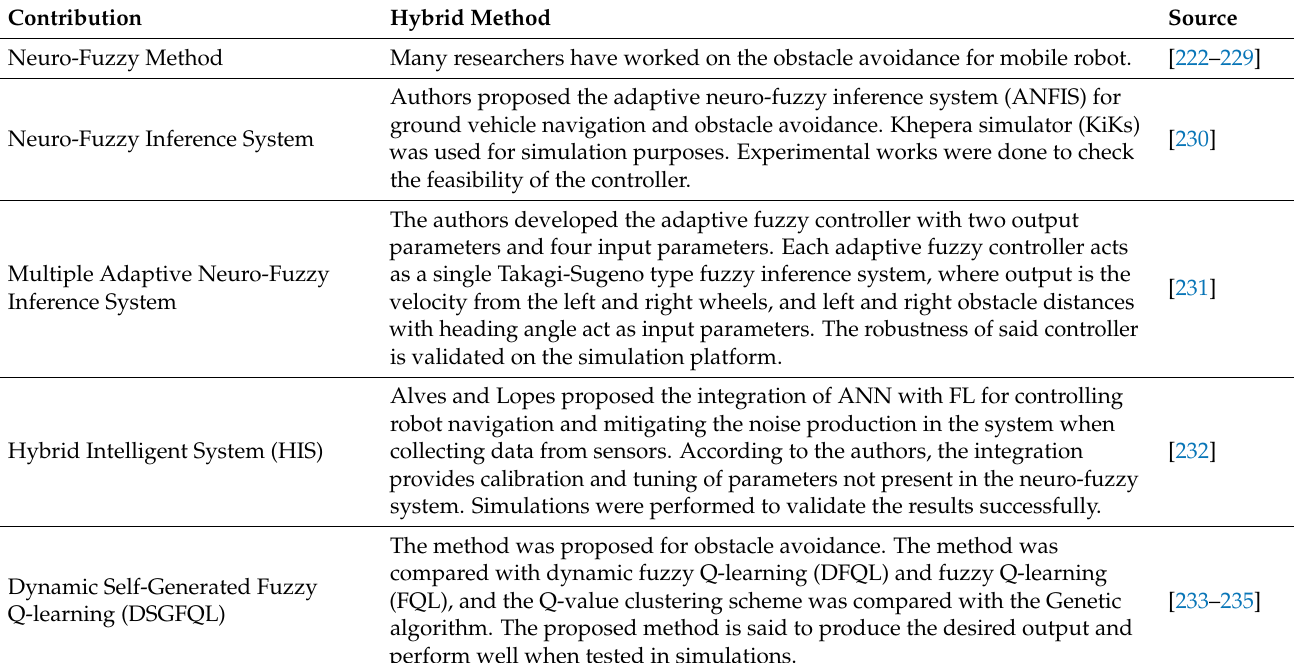
Table 6. Impact of Hybrid Methods Involve in Ground and Aerial Vehicles Contribution Hybrid Method Source Neuro-Fuzzy